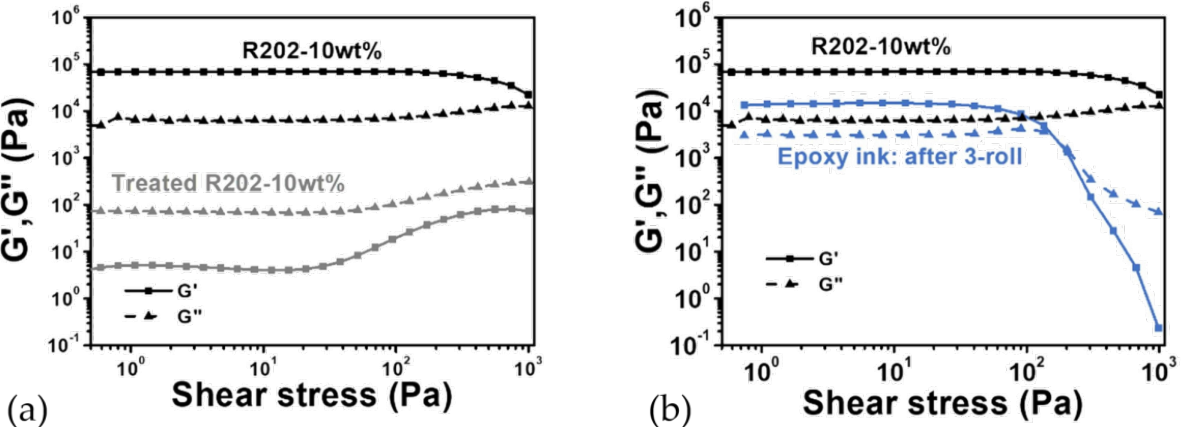
Figure 19. Storage modulus and loss modulus over shear stress of ( a ) 10 wt% nanosilica/epoxy component and nanosilica treated under high temperature, ( b ) before and after 3-roll milling [189]. Copyright © 2022 Elsevier.